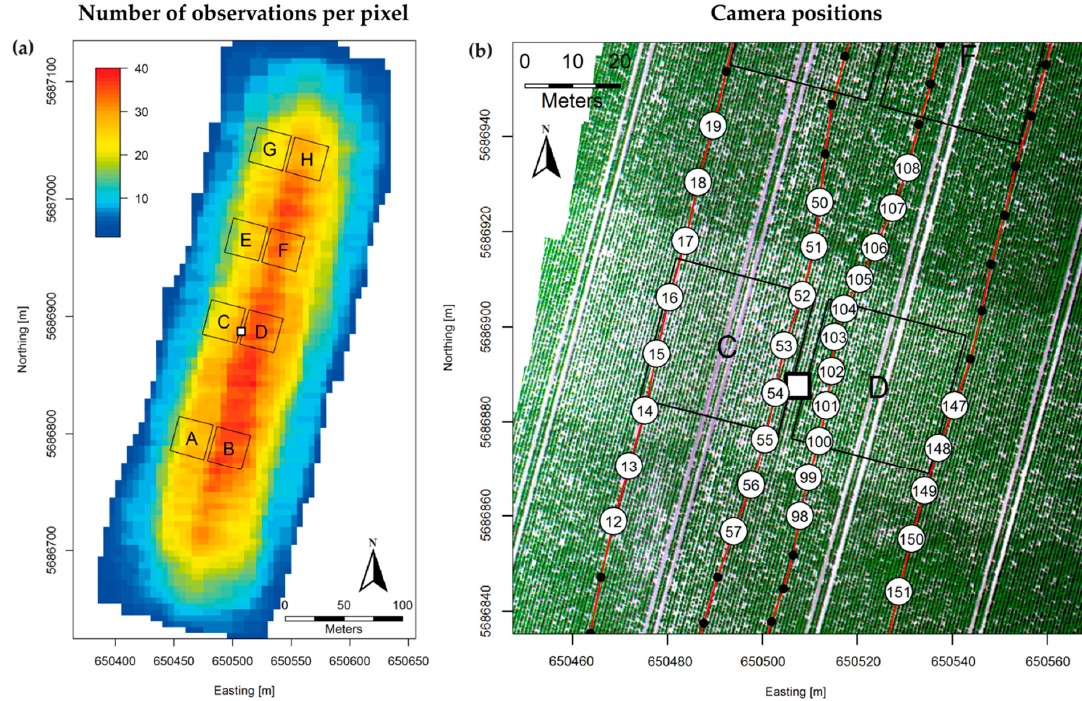
Figure 4. The number of observations per pixel, captured during the flight on 9 June 2016, at 658 nm ( a ). The camera positions (numbers in white circles) from which an example pixel (white square between Plot C and D) was captured ( b ). The red lines indicate the flight path of the UAV and the black dots indicate the camera positions that did not capture the example pixel. Both ( a ) and ( b ) are in WGS84 UTM 31N projection.